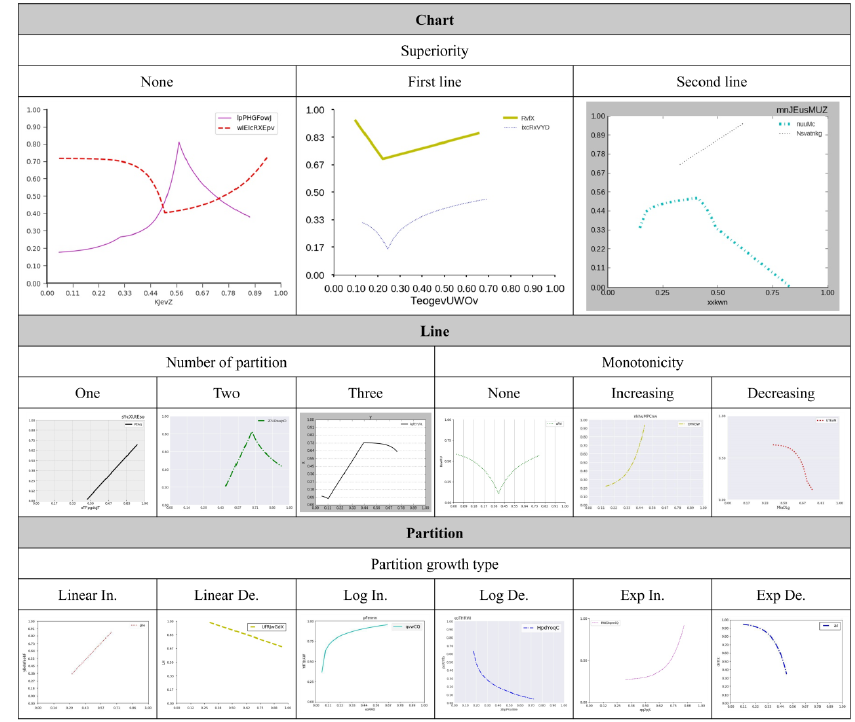
Figure 2. Examples of the generated input images and labels for classification subtasks (In., increasing; De., decreasing).